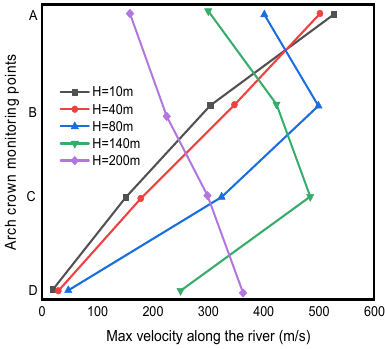
(d) Max velocity of the arch crown beam monitoring points along the river Figure 16. Cont